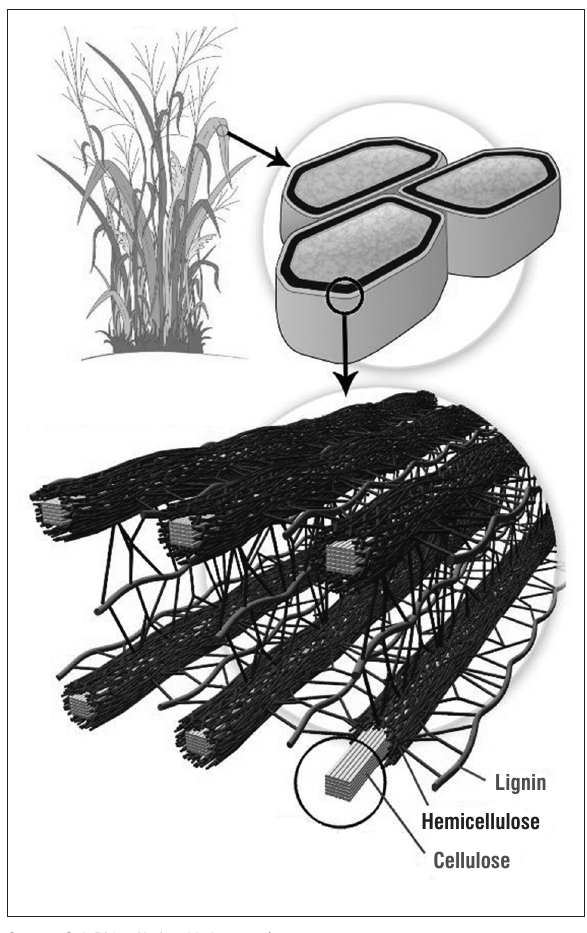
Figure 2: Spatial representation of cellulose, hemicellulose and lignin in lignocellulosic